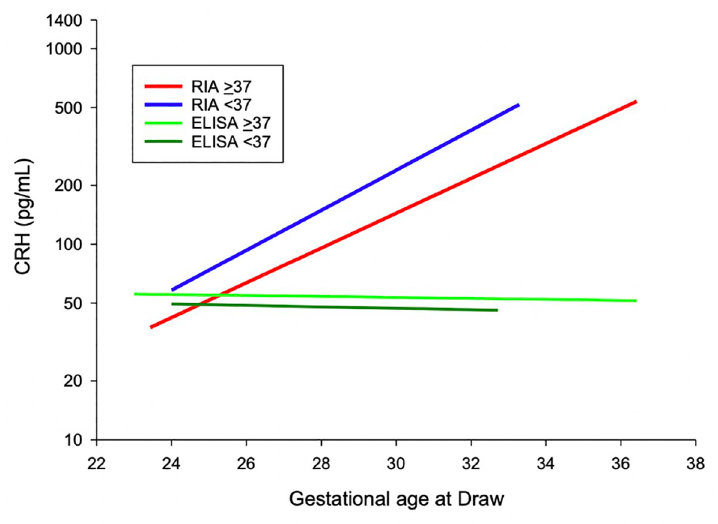
Fig 3. Initial CRH levels at 24 and 32 weeks by delivery outcome of < 37 weeks as obtained by enzyme-linked immunosorbent assay (LifeSpan Biosciences) without extraction and by radioimmunoassay with extraction. Compared to radioimmunoassay with extraction, enzyme-linked immunosorbent assay without extraction results in assay binding interference and non-significant results. Enzyme-linked immunosorbent assay = ELISA, radioimmunoassay = RIA.